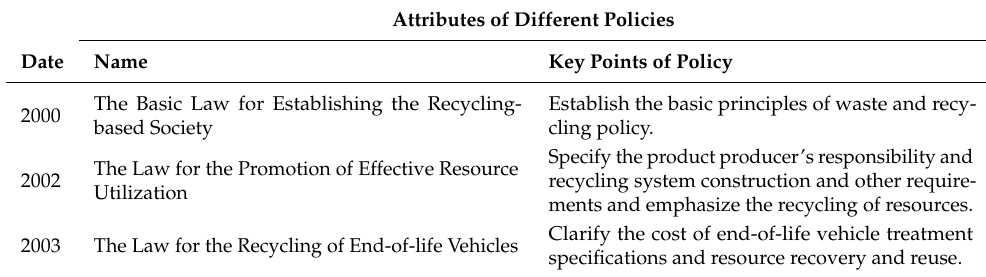
Table 3. Laws on EoL power battery recycling in